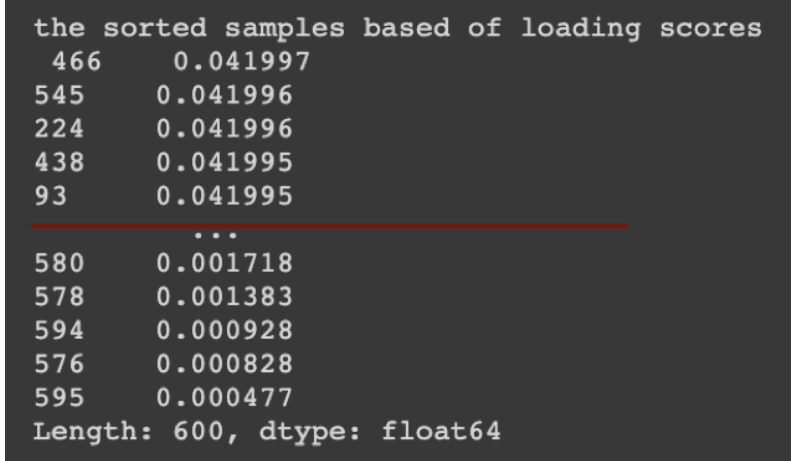
Figure 16. Scree plot of the breast cancer classification.